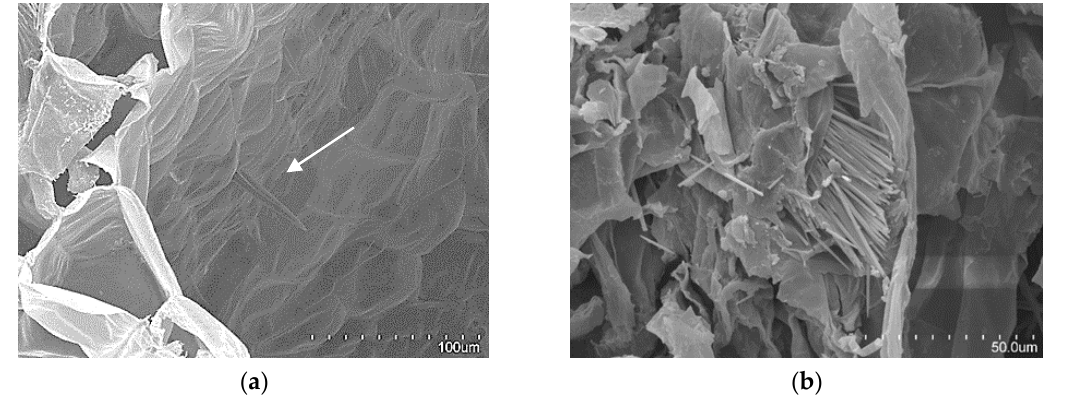
Figure 6. Aerenchyma tissue SEM image, showing sclereid cells projecting into air space ( a ). Needle-like crystals of oxalate calcium ( b ). Table 1. Physical characterization of WH petiole (WHP).